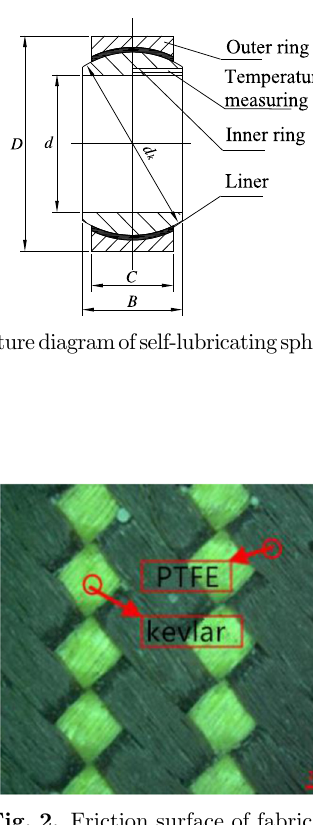
Fig. 2. Friction surface of fabric